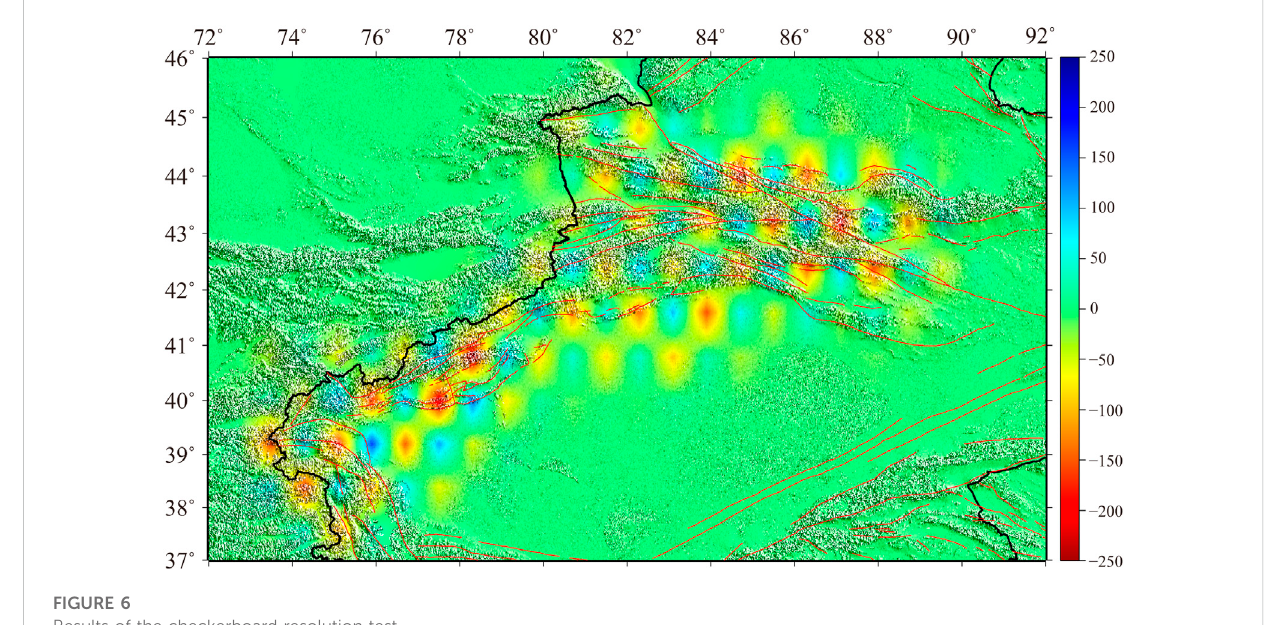
FIGURE 6 Results of the checkerboard resolution test.